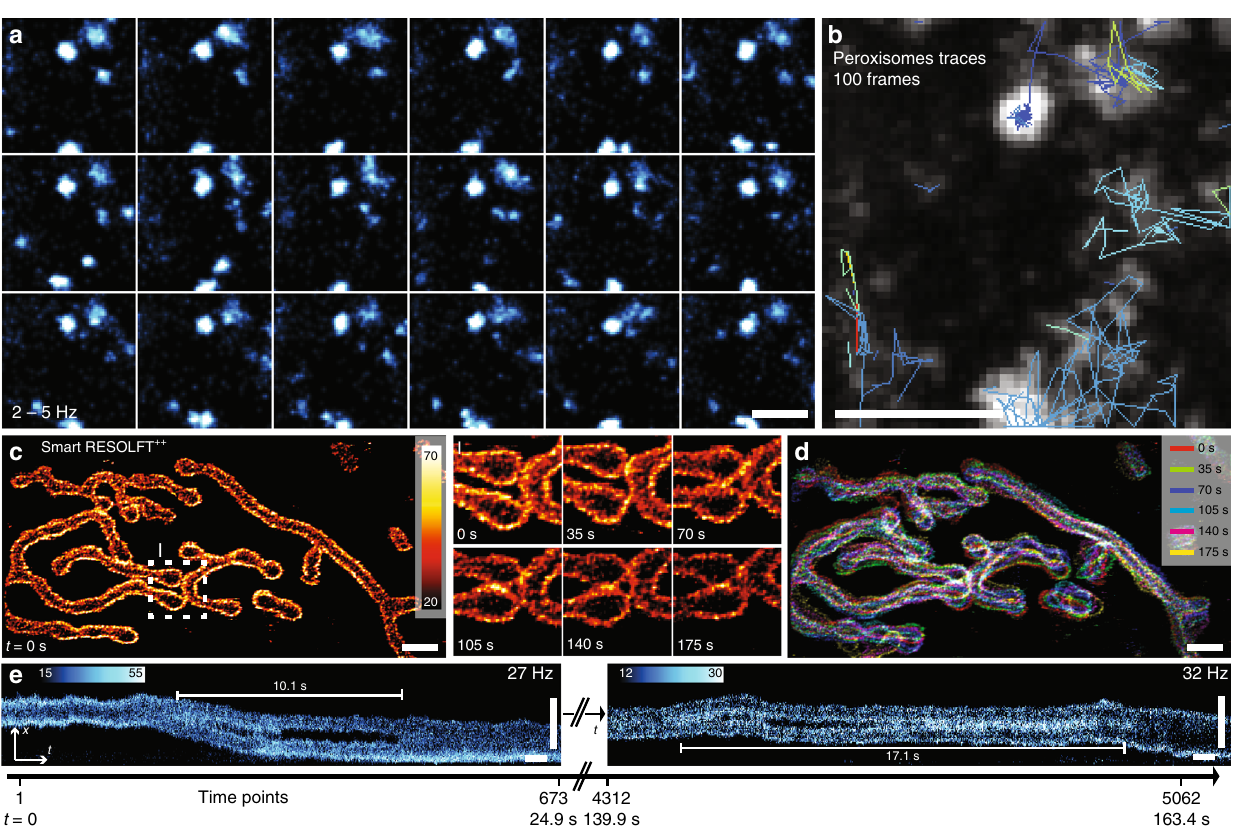
Fig. 5 Rapid time-lapse imaging of organelles with smart RESOLFT. a , b We imaged the continuous interplay of peroxisomes over 100 time points recorded at 2 – 5 Hz. Pex16-rsEGFP2 was expressed in U2OS cells. The decision was made with probe type 1. a The fi rst 18 frames of the time lapse are shown. Each image has been smoothed with a 30 nm radius Gaussian fi lter. b Maximum projection of the entire 100 frames time-lapse. Few selected peroxisome trajectories are shown in different colors. c , d Mitochondria dynamics in U2OS cells. The mitochondrial outer membrane was labeled with rsEGFP2 with a targeting sequence of Omp25. c Time lapse recorded in the smart RESOLFT mode. The fi rst frame is shown in the fi re color bar. The related region of interest ROI I shows mitochondrial membranes fusion over time. d Maximum projection of the time-lapse mitochondria imaging. Each image is color coded and identify the fraction of mitochondria with minimal mobility (white) from the mobile one (colored) in the seconds time frames. e To detect real-time (30 Hz) dynamics of the individual mitochondria we performed a line recording xt-scan over thousands of time points. We observed sequential fi ssion and fusion of the outer mitochondrial membrane with sub-80nm spatial resolution. Scale bars are 1 µ m ( a − d ), for ( e ) the vertical scale bar is 1 µ m and the horizontal 1 s. RESOLFT REversible Saturable/Switchable Optical Linear Fluorescence